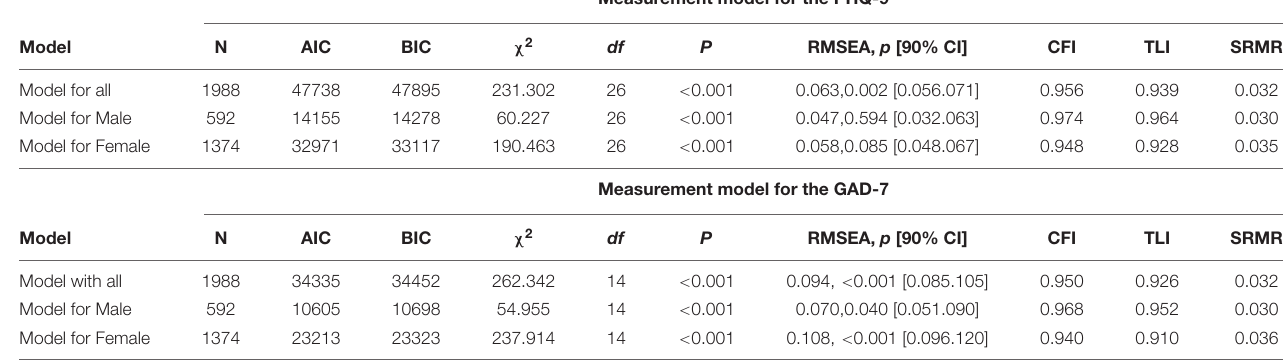
Measurement model for the PHQ-9